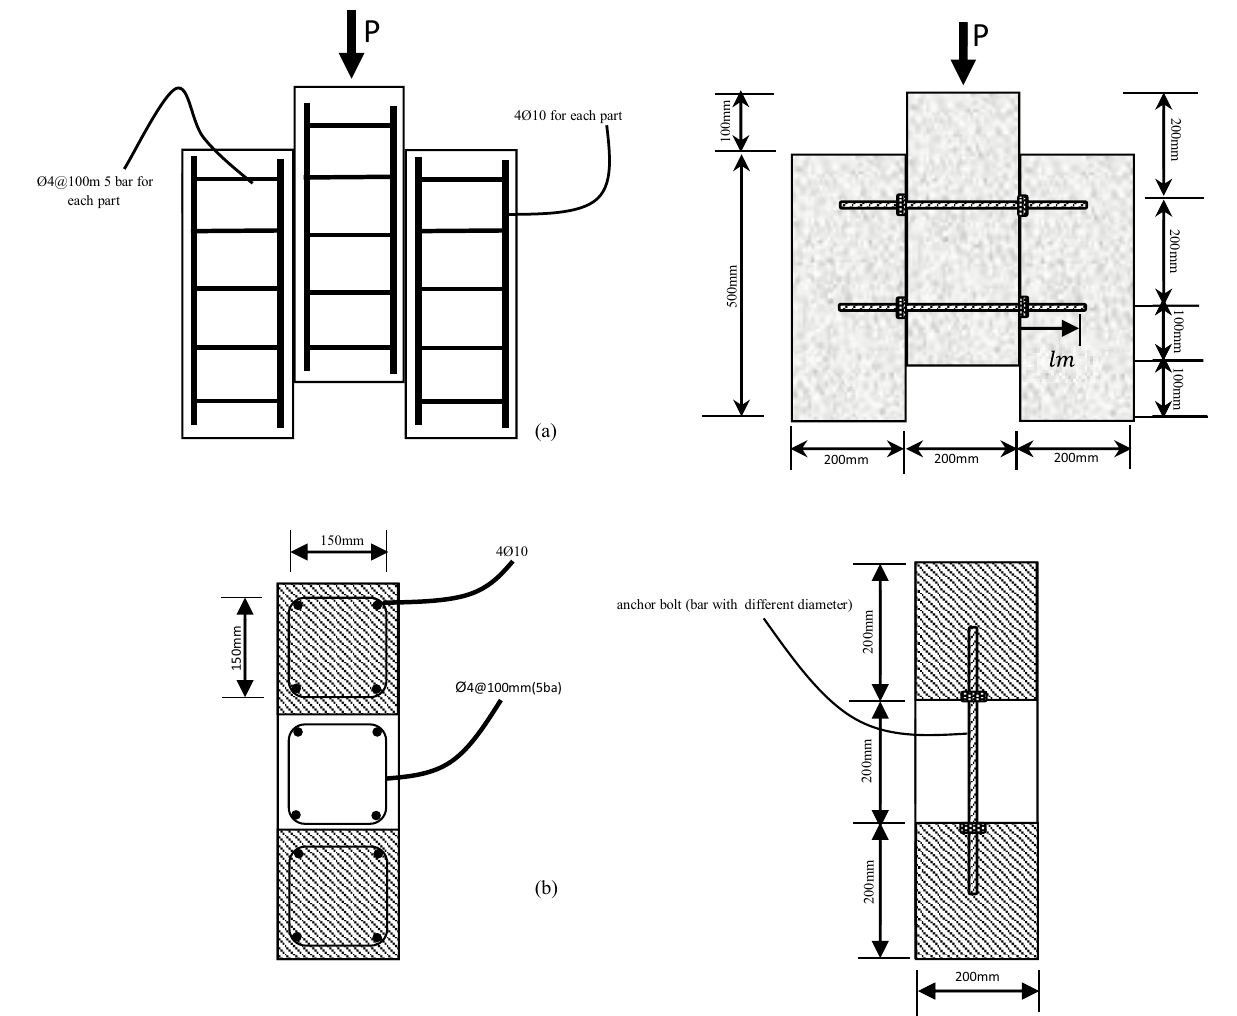
Figure 1: Dimensions of pushout specimens. ( a ) Front view; ( b ) top